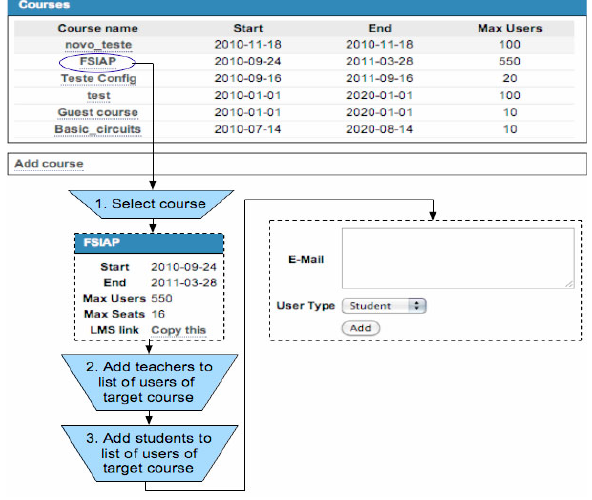
Figure 2. Adding a list of users to a given course, in VISIR